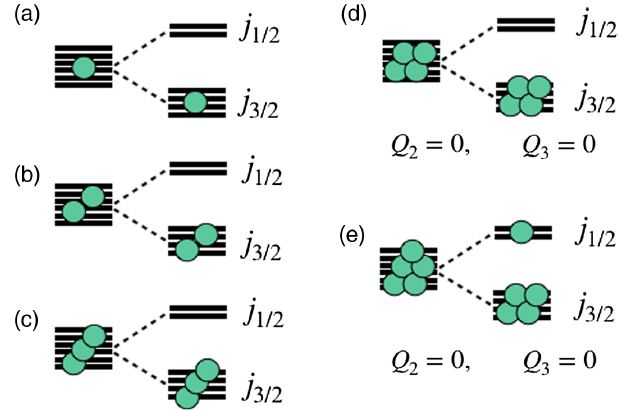
FIG. 3. Level splitting diagrams due to spin-orbit coupling for different number of electrons, the case of the jj coupling scheme (very large λ